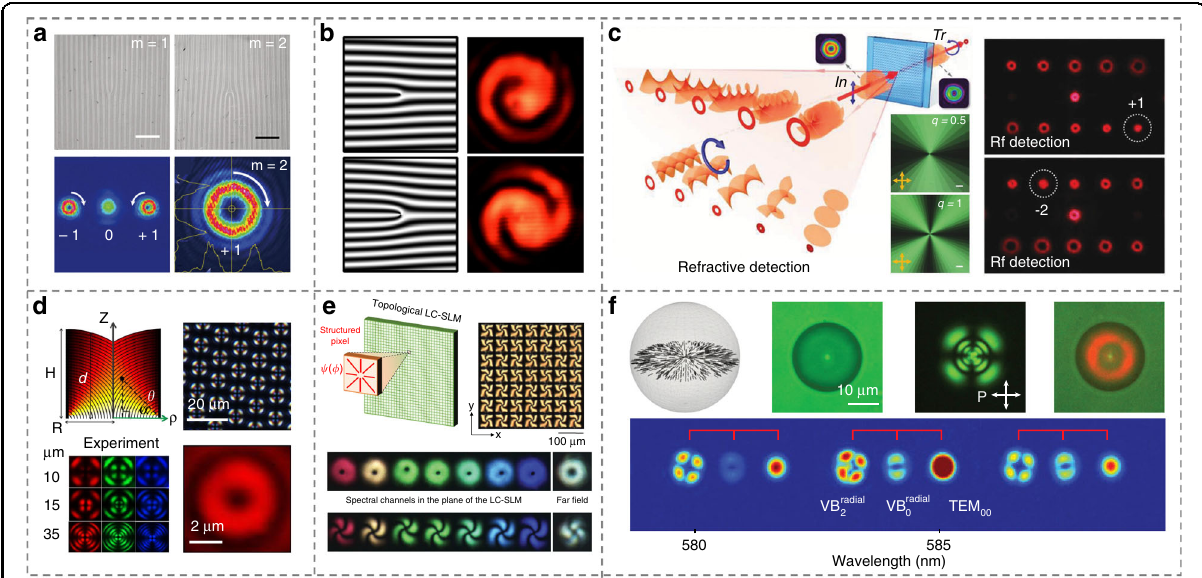
Fig. 12 LCs for light fi eld modulation devices. a Transmissive vortex beams generated by diffraction fork gratings in NLCs 67 . Reproduced from ref. 67 , with permission from Wiley-VCH. b Re fl ective vortex beams generated by diffraction fork gratings in CLCs 240 . Reproduced with permission from ref. 240 . Copyright 2016, American Physical Society. c Detection of OAM modes by CLC Dammann fork gratings 241 . Reproduced from ref. 241 , with permission from Wiley-VCH. d Large area optical vortex arrays based on FCDs in SLC 99 . Adapted with permission from ref. 99 © The Optical Society. e Spatial and temporal modulation of multispectral light fi elds by a programmable LC SLM 245 . Reproduced with permission from ref. 245 .